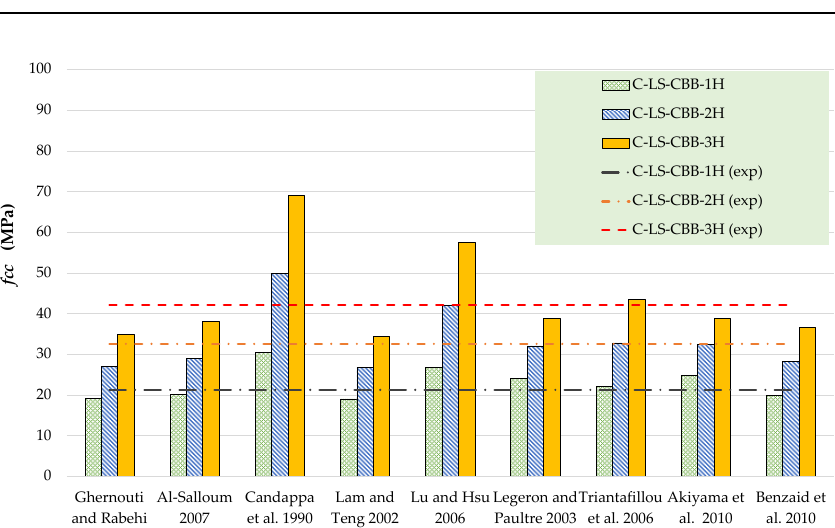
Figure 13. Comparison of strain for Type-1 group [31 – 39].